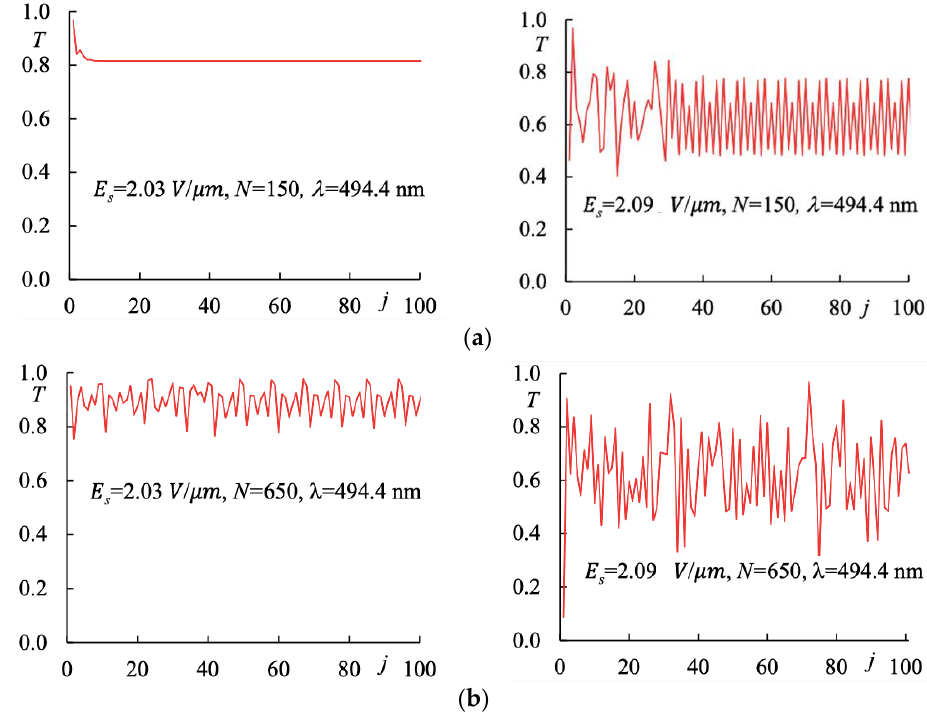
Figure 6. The transmittivity vs. the index j at wavelengths 1 = 494.4 nm for two different values of the applied static field: E S = 2.03 V / mm (curves on the left) and E S = 2.09 V / mm (curves on the right): ( a ) N = 150; ( b ) N = 650.